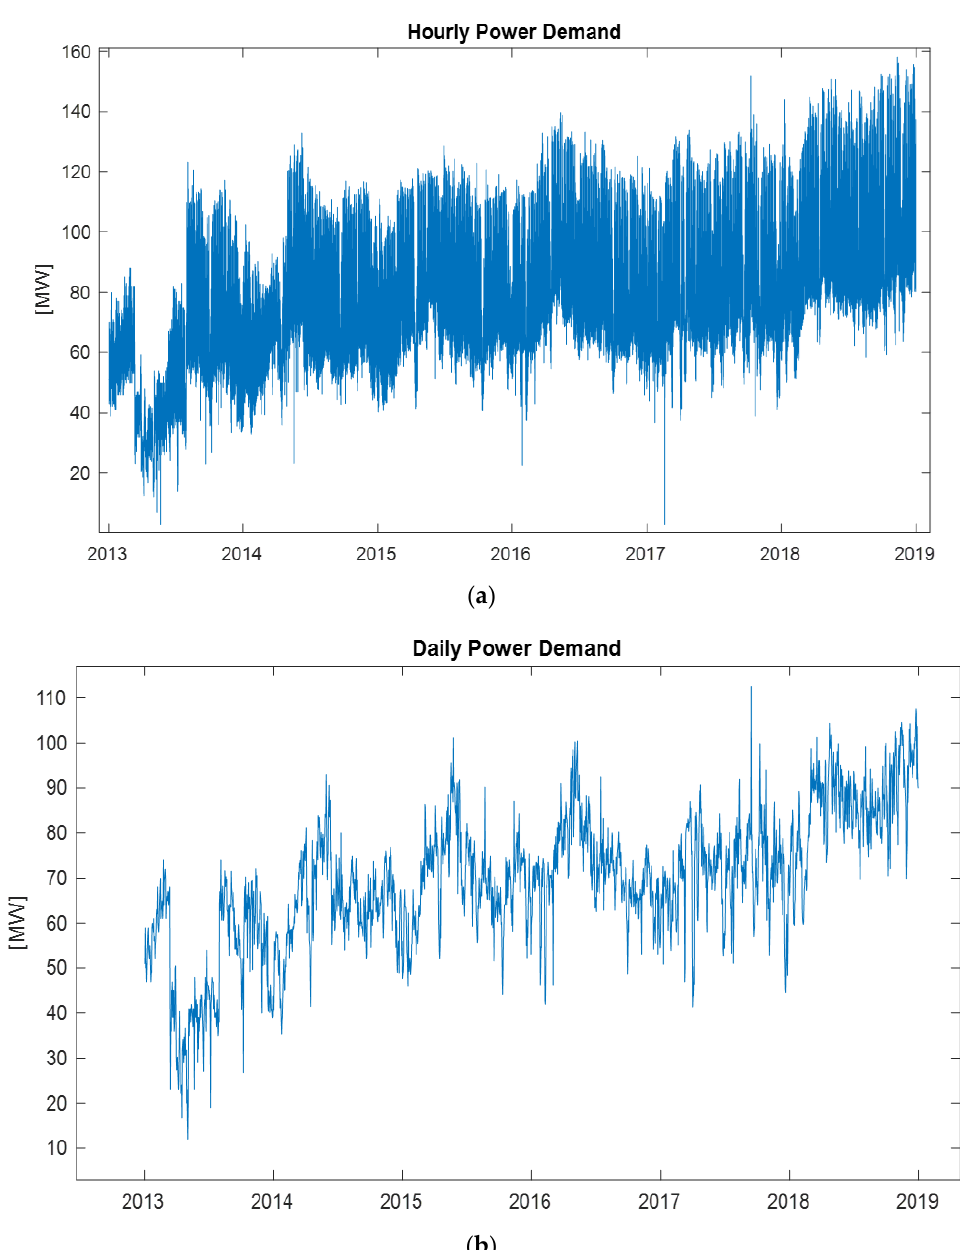
Figure 2. ( a ) The original hourly power demand dataset at the GS1 site and ( b ) the converted daily power demand dataset from the hourly demand.